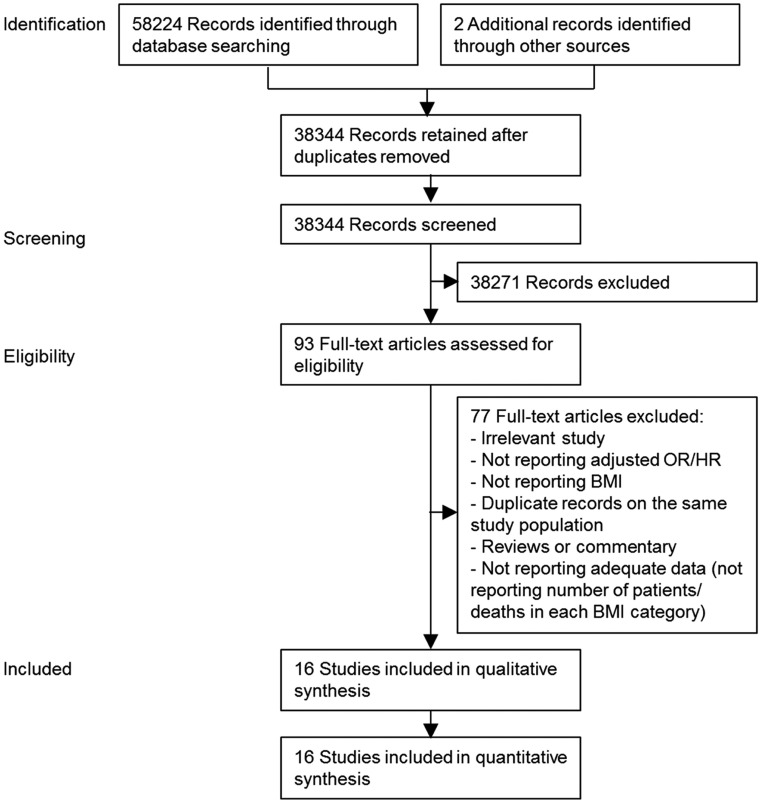
Flow diagram for the selection of studies.